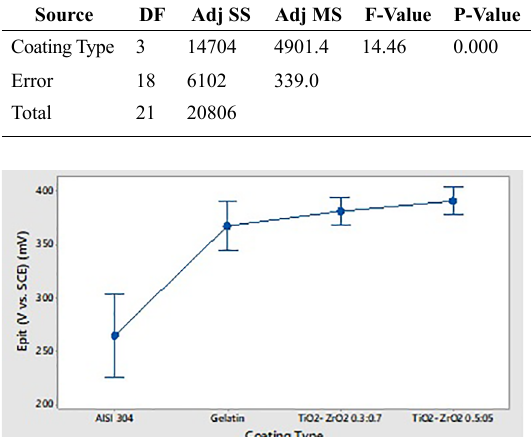
Figure 14: Interval plot of the critical pitting potential (V vs. SCE) (mV) versus the examined sample